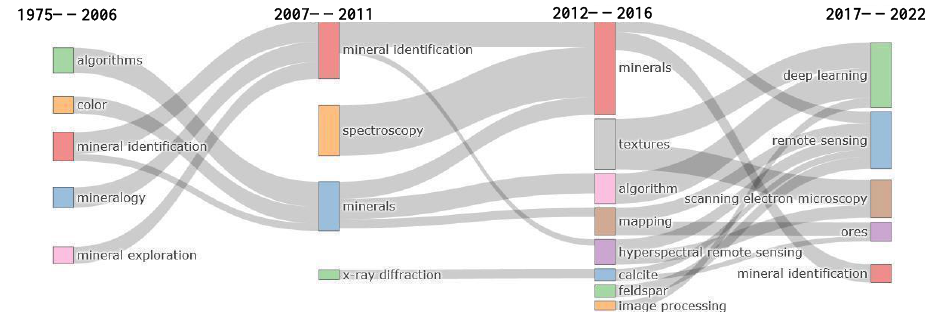
Figure 2. Thematic evolution diagram for the field of intelligent mineral